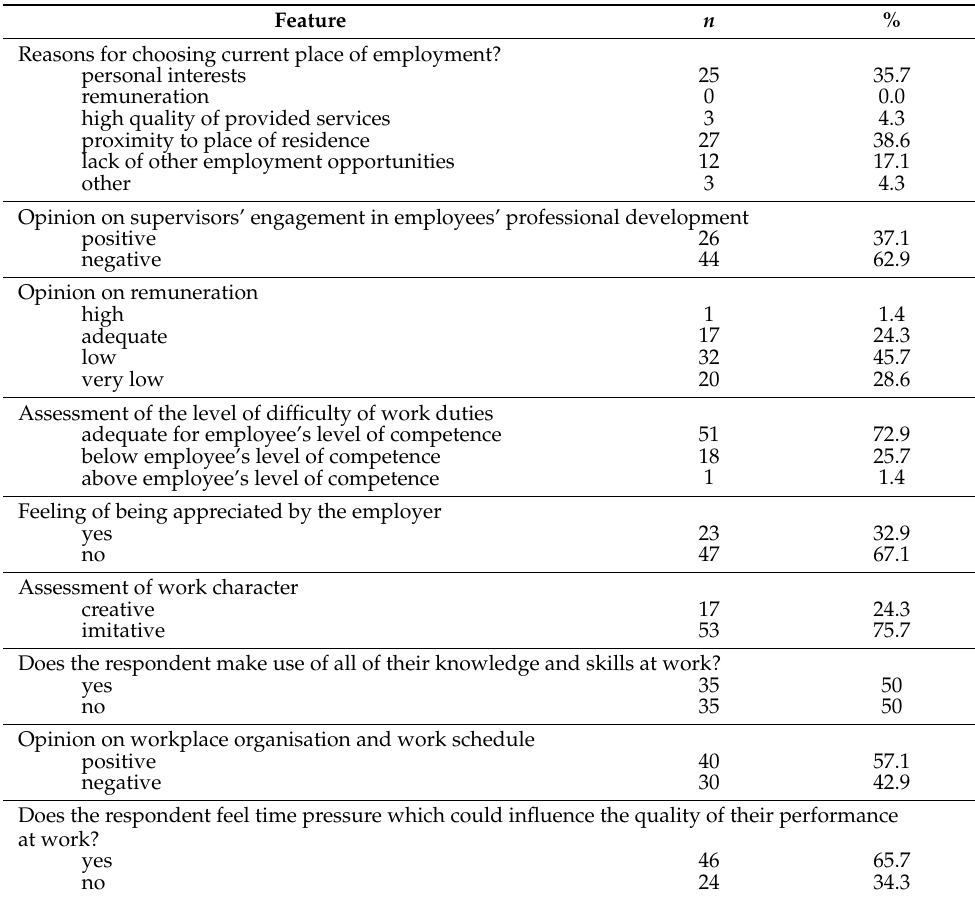
Table 2. Results of the authors’ own questionnaire. Feature n